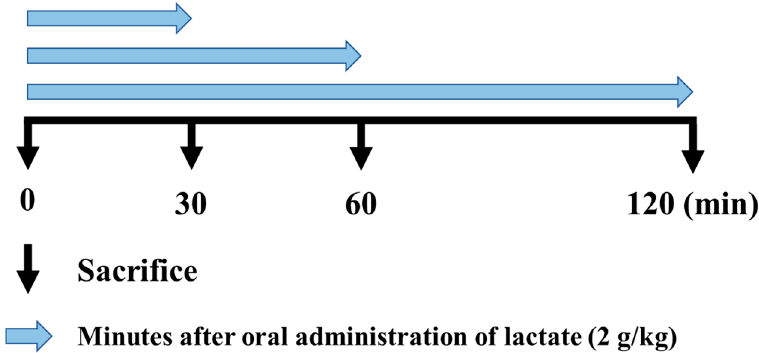
Figure 1. Study design. Blood and muscle samples were obtained at the indicated time points after oral lactate administration to analyze mRNA expression levels and blood (plasma) parameters.